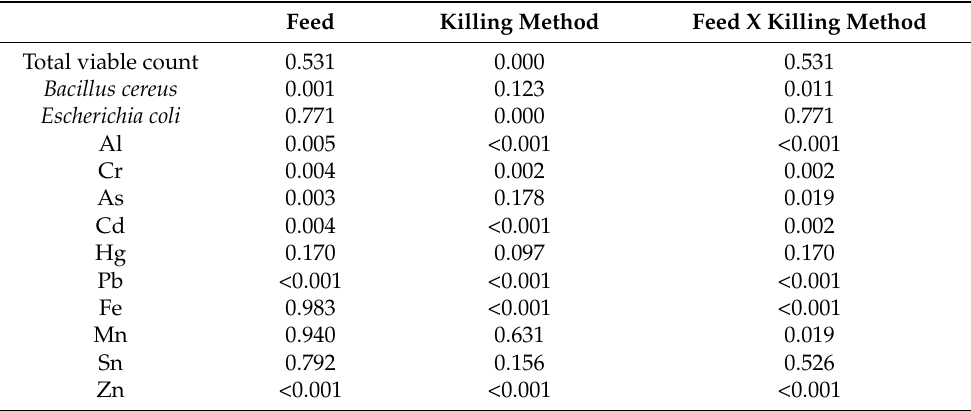
Table 2. The p -values indicating the impact of feed and treatment on the various heavy metals and microbial counts measured for black soldier fly larvae.